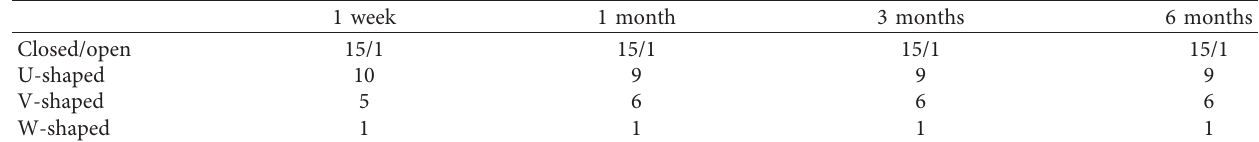
Table 2: Postoperative foveal appearance at SD-OCT examination.